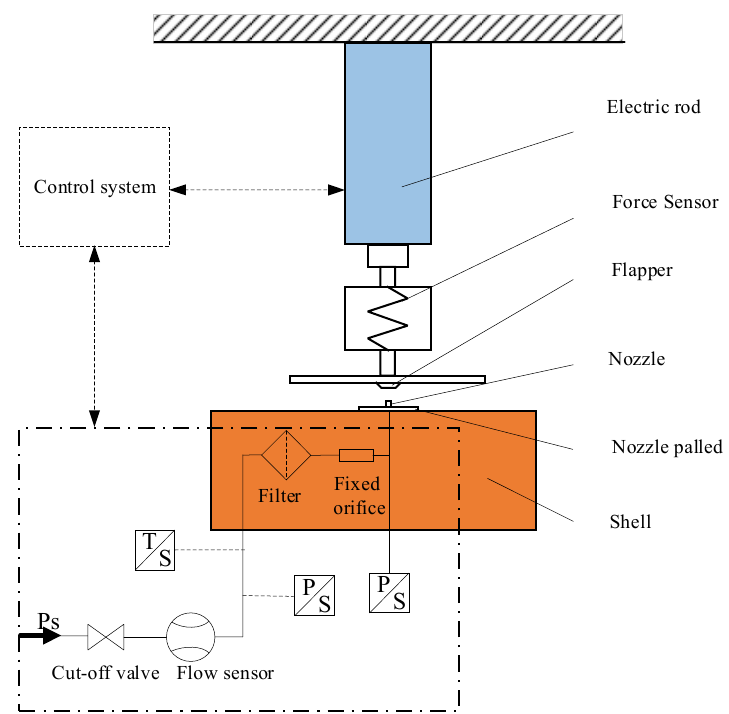
Figure 19. Schematic diagram of the experimental device.